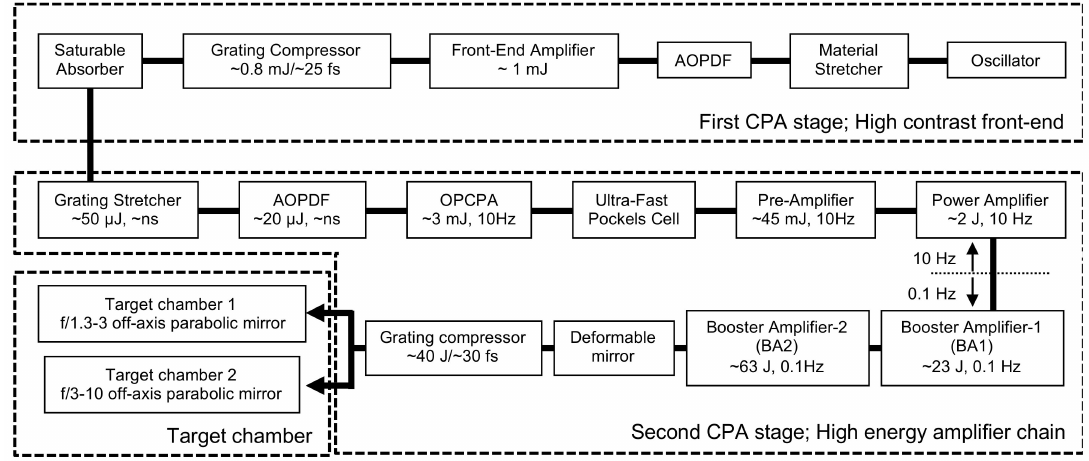
Figure 1. Schematic diagram of the J-KAREN-P laser system at KPSI,